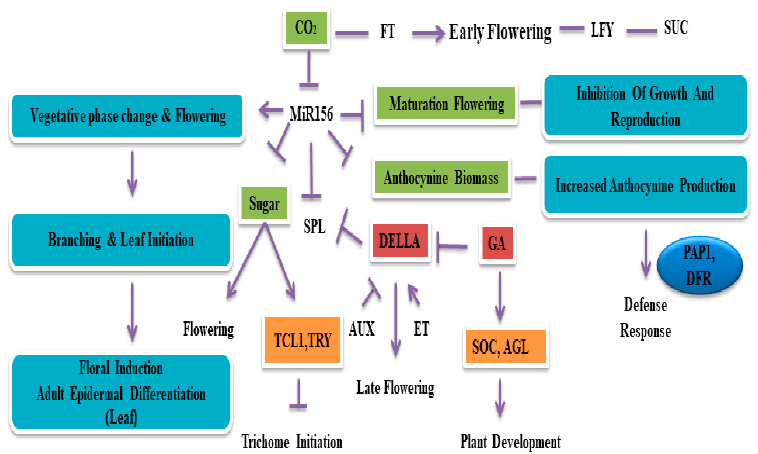
Figure 3. Applications of miR156/SPL gene regulation for crop improvement. miR156/SPL interaction promotes vegetative phase transition to flowering, branching/mineralization, and new leaf germination. Many endogenous and environmental cues can also accelerate phase transitions. Recent findings also indicate that plant hormones, such as auxin and ethylene, regulate the expression of miR156. The negative regulation of miR156 by sugars ensures flowering and trichome initiation. The DELLA proteins interact and repress SPL protein activities. Therefore, miR156/SPL module plays a versatile role in genetic crop improvement.